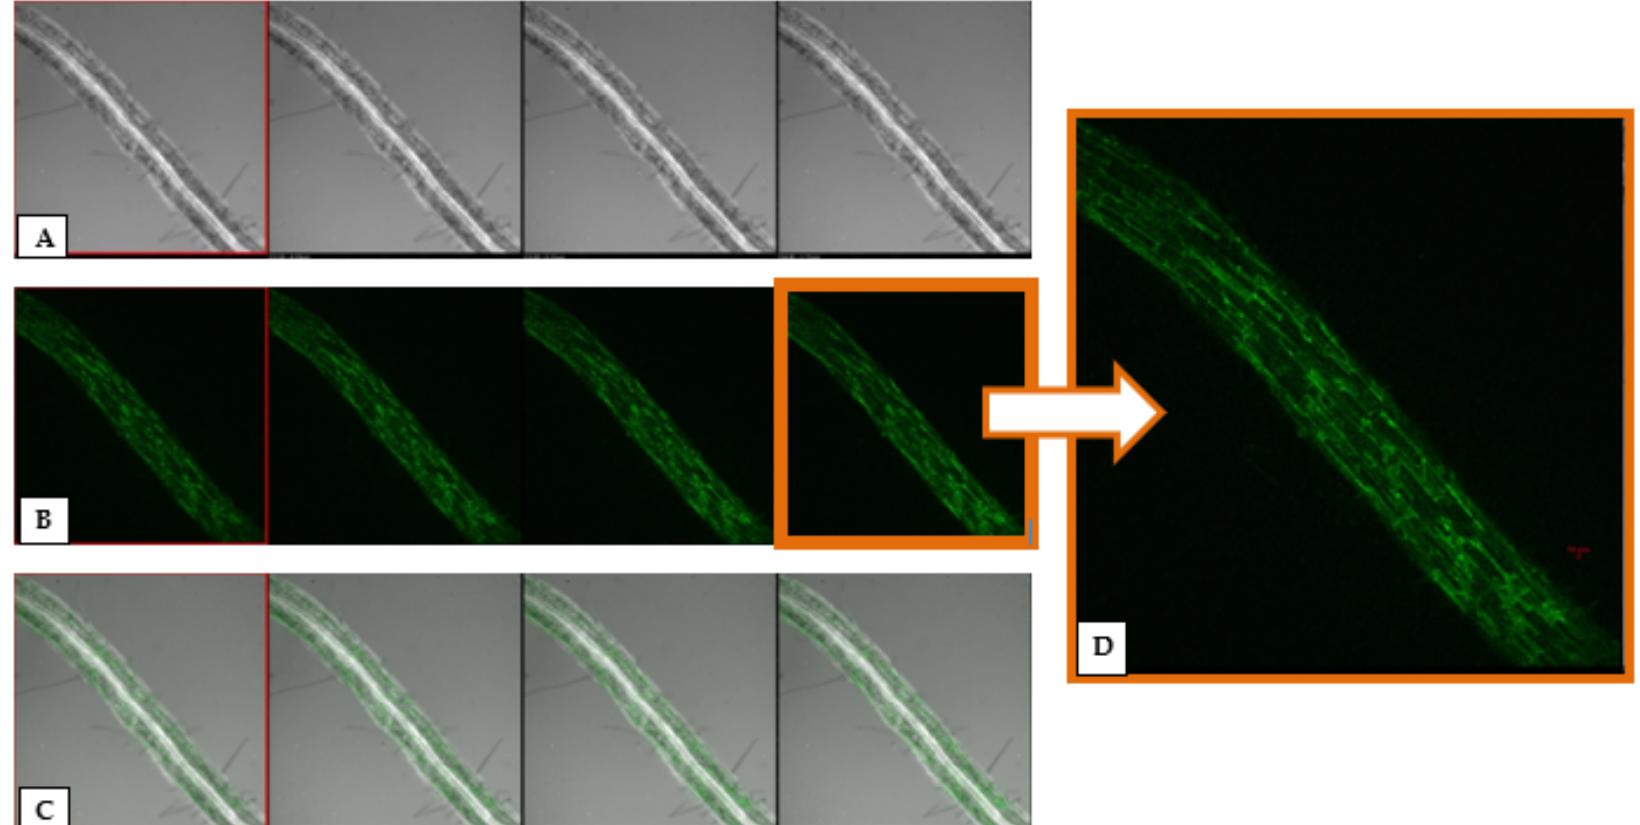
Figure 2. Z-stack of maize root visualized under confocal scanning laser microscopy indicating localization of Green fluorescent protein (GFP)-tagged Pseudomonas aeruginosa MF-30 in the maize roots (10 × ). ( A ) Z-stack of di ff erent planes from Transmission Detector (TD) channel, ( B ) Z-stack of di ff erent planes from 488 nm channel, ( C ) Z-stack of di ff erent planes from both TD and 488 nm channel, and ( D ) magnified X–Y plane image of maize roots showing colonization of MF-30 by GFP fluorescence.